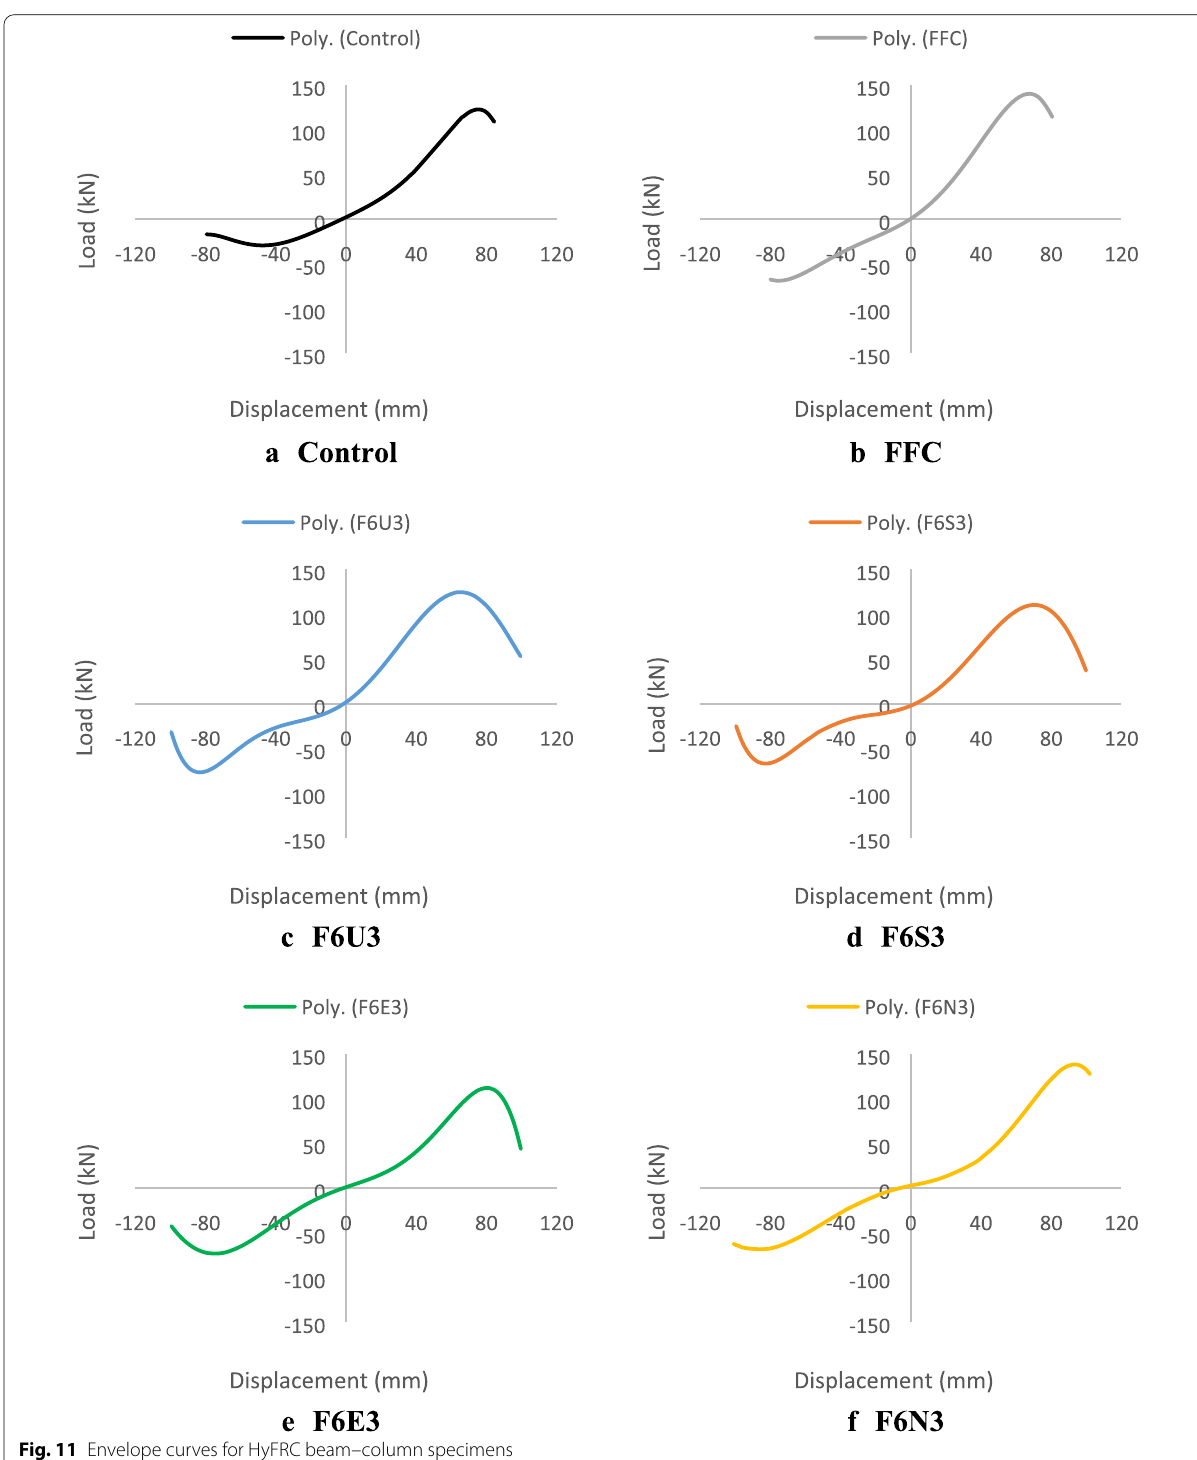
Fig. 11 Envelope curves for HyFRC beam–column